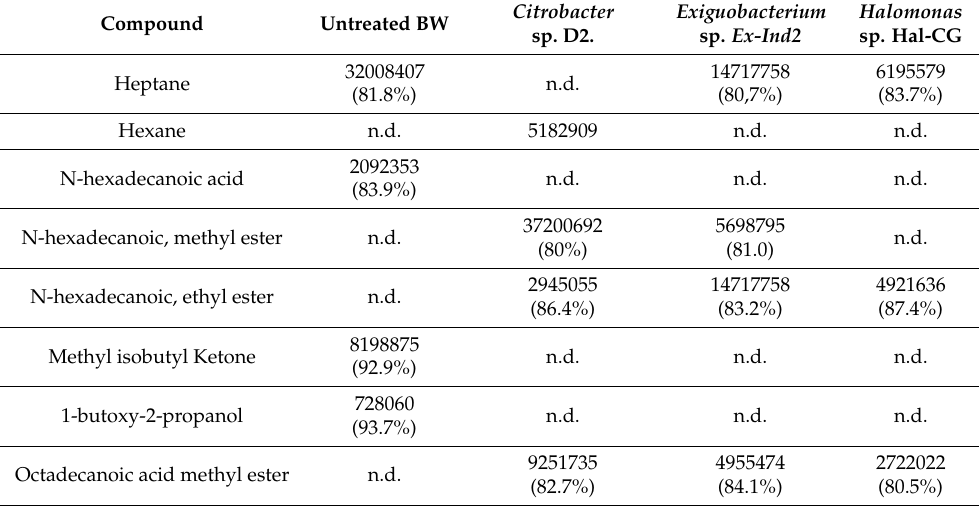
Table 2. Major organic compounds detected in untreated and treated bilge water by isolated bacterial strains after GC-MS analysis. % Probability according to NIST 5 Library is given in the